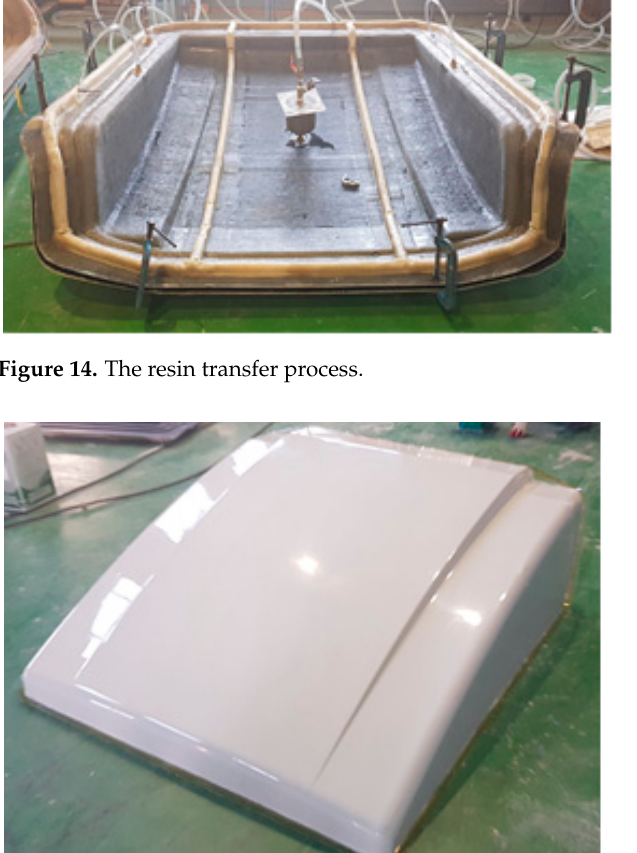
Figure 16. The process of tolerance test. Figure 17. The measurement point for the tolerance test. 7. Conclusions In this study, structural design and analysis was performed for 3.5-ton commercial vehicles equipped with a fairing, and the following conclusion was drawn: The load case 2 condition, which is the highest driving speed (130 km/h) of commercial vehicles and